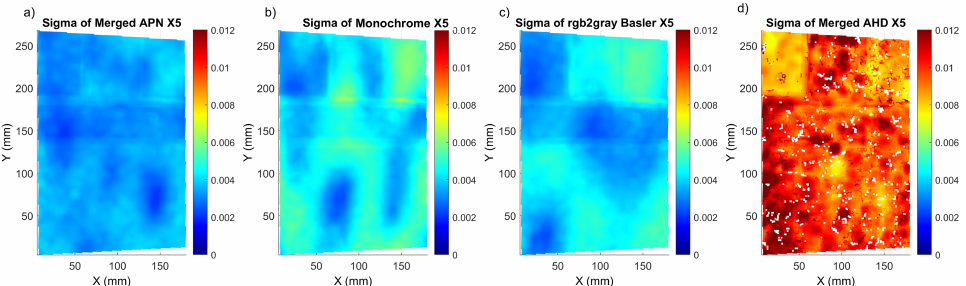
Figure 4. Correlation coefficient (sigma) maps corresponding to X5 shift for: ( a ) merged APN, ( b ) Monochrome, ( c ) rgb2gray Basler and ( d ) merged AHD methods